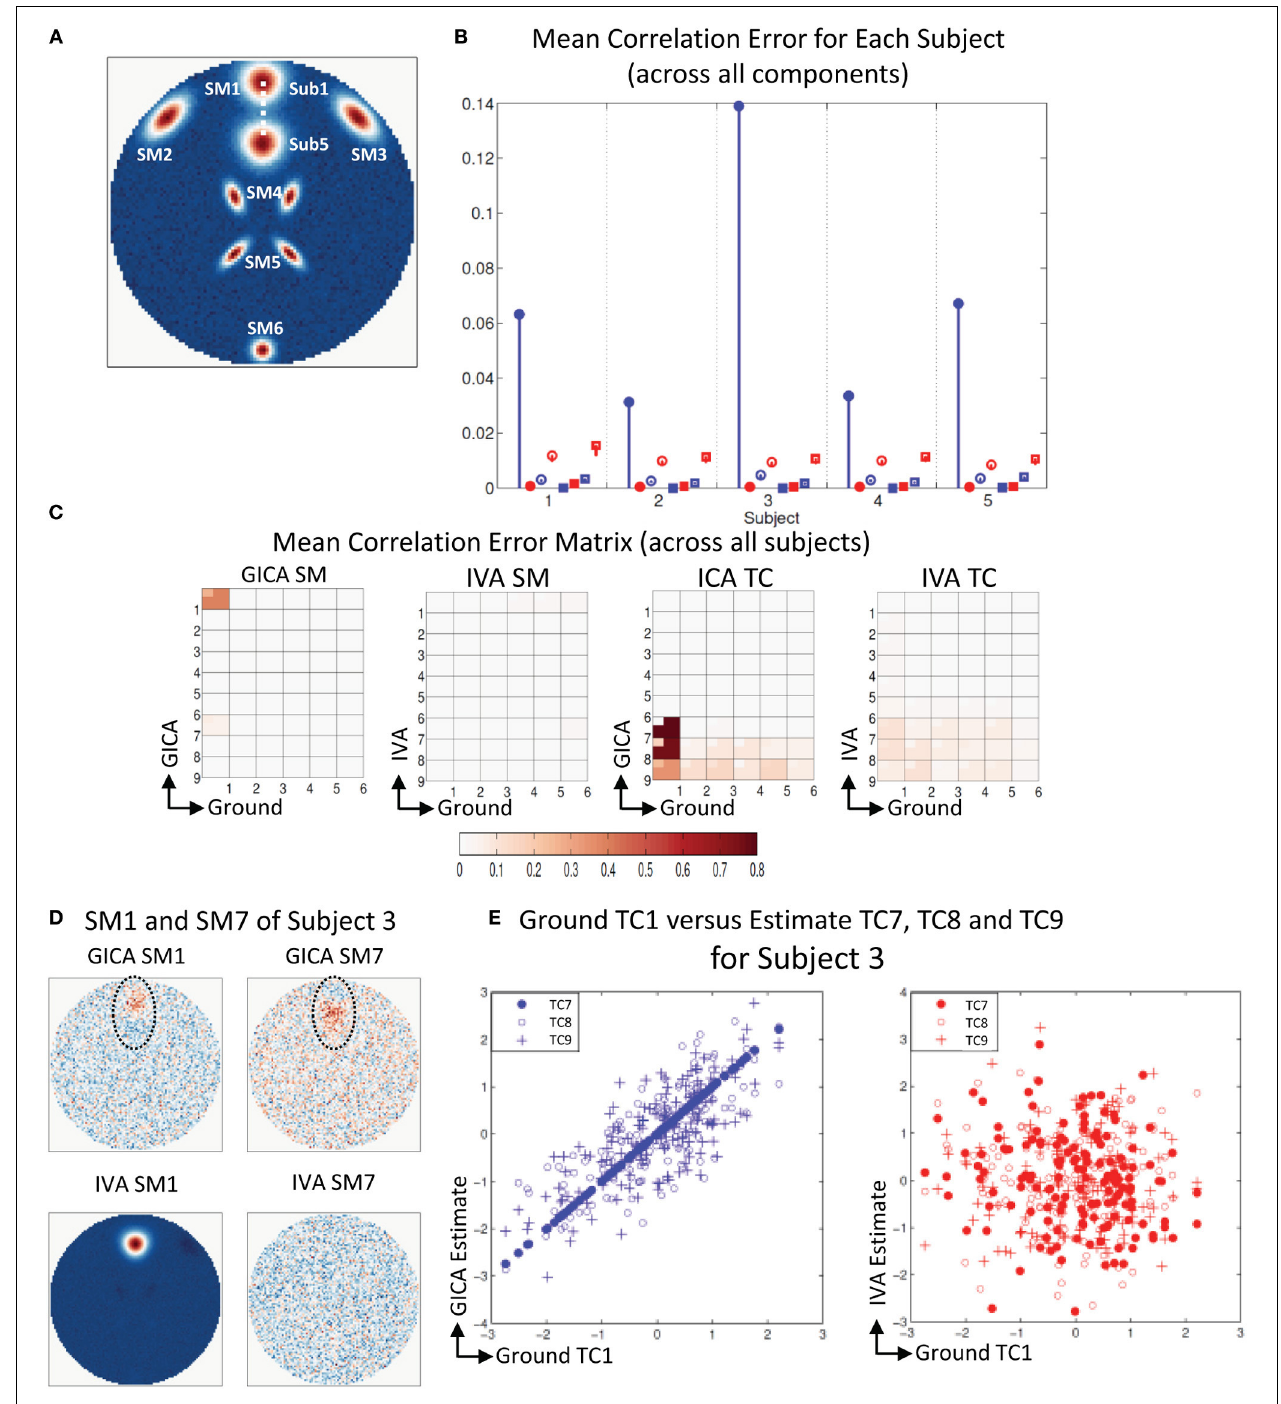
FIGURE 5 | Results of Experiment 2f: Over estimation of components (6 components are estimated with 9). (A) All SMs, except SM1, spatially overlap across subjects. SM1 is spatially varied for all subjects. Locations of SM1 for Subjects 1 and 5 are shown and SM1 for other subjects are equally spaced between those locations. (B) Mean correlation errors across all components, presented for each subject separately. Mean errors are in blue for GICA and in red for IVA. Diagonal elements of the correlation error matrix